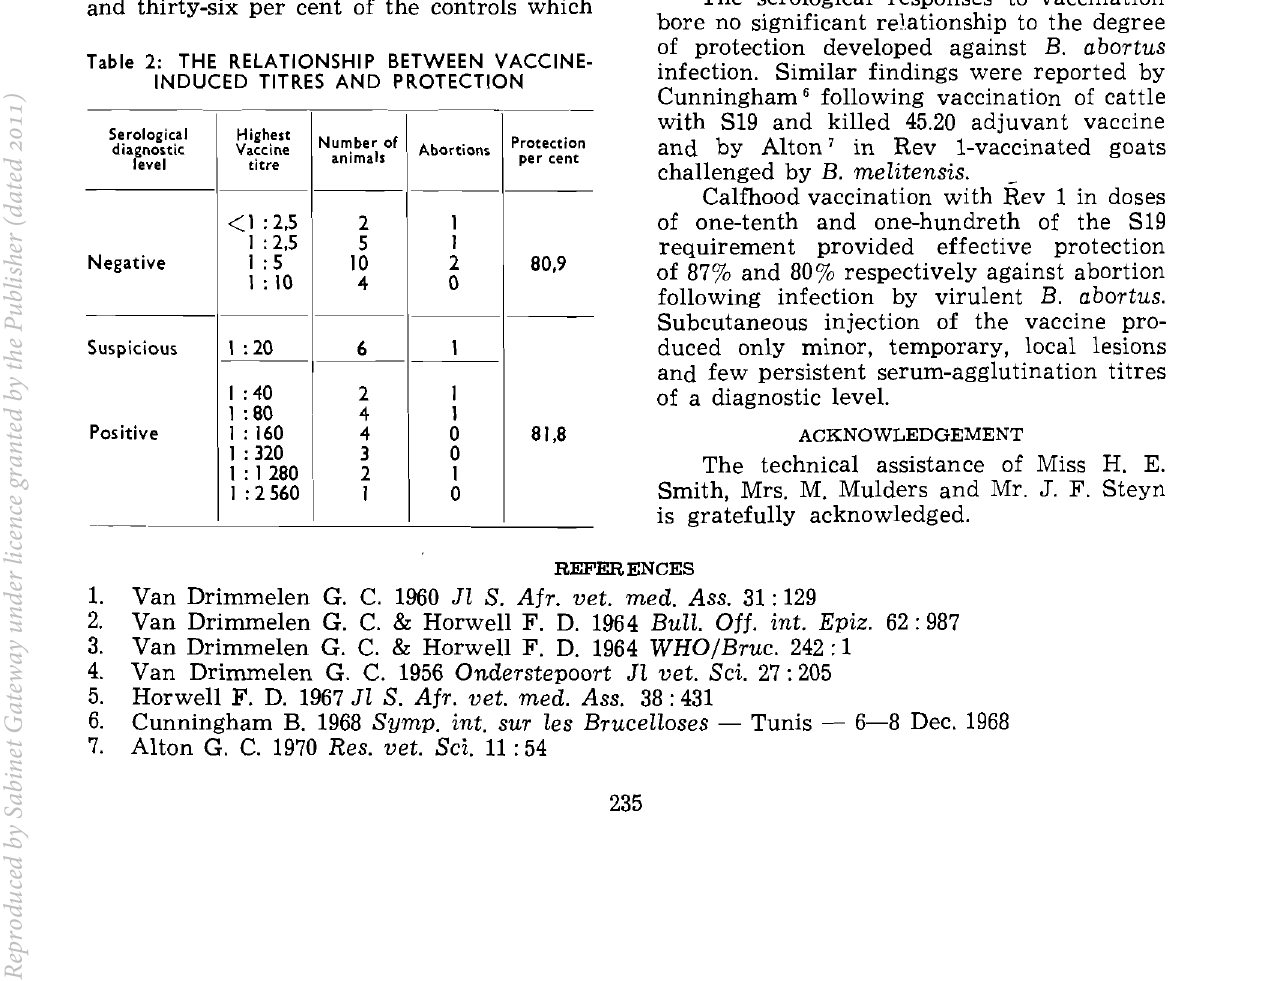
Table 2: THE RELATIONSHIP BETWEEN VACCINE INDUCED TlTRES AND PROTECTION